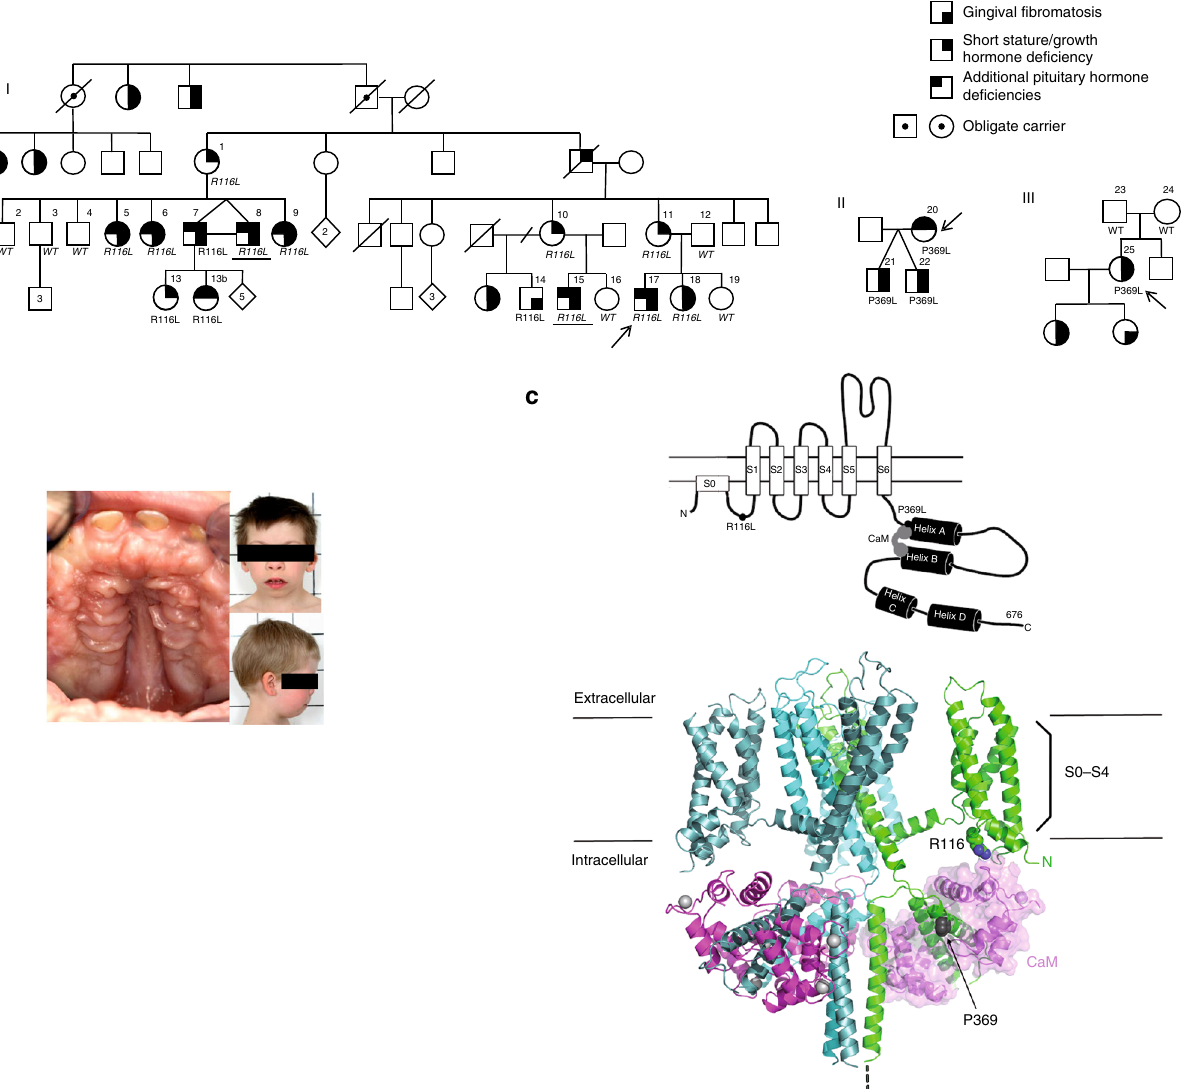
Fig. 1 Pedigrees, gingival fi bromatosis and craniofacial features, and KCNQ1 structure. a (I) Pedigree of the large Finnish family showing autosomal dominant growth hormone de fi ciency and maternally inherited gingival fi bromatosis. The genotype (wild-type (WT) or p.(Arg116Leu)) is given. The samples included in the linkage analysis are indicated in italics, and samples included in whole-genome sequencing are underlined. Two additional families with the same disease but another mutation in KCNQ1 , p.(Pro369Leu), were identi fi ed: a Finnish trio (II) and a family (III) originating from Argentina. Note that the index patient in pedigree III has a de novo mutation. b Maternally inherited gingival fi bromatosis is shown together with the craniofacial features of the twin boys belonging to family II. c Schematic of the KCNQ1 channel protein and the location of the two missense mutations in the 3D channel structure. The schematic shows the membrane domain, with helical segments S0 – S6 and the intracellular domain, divided into a membrane-proximal module (helices A – B) bound by CaM and a distal module (helices C – D), responsible for tetramerization. Filled circles with labels show the positions of the mutations, Arg116Leu and Pro369Leu. The double lines depict the plasma membrane. Below the schematic is a molecular graphics depiction of the Kv7.1/CaM channel complex as based on the cryo EM Xenopus structure (PDB code: 5VMS) 11 . The channel subunits are colored green, cyan, and teal. CaM is colored pink and shown with a surface representation on the right side. Gray spheres are Ca 2+ ions. Again, the straight lines denote the probable location of the plasma membrane. The residues that undergo mutation are drawn as CPK atoms and are labeled. One channel subunit of the tetramer and its respective CaM molecule have not been drawn in order to facilitate visualization. The helix D tetrameric coiled-coil 62 was not observed in the cryo EM study due to fl exibility in the linker between it and helix C and hence not drawn